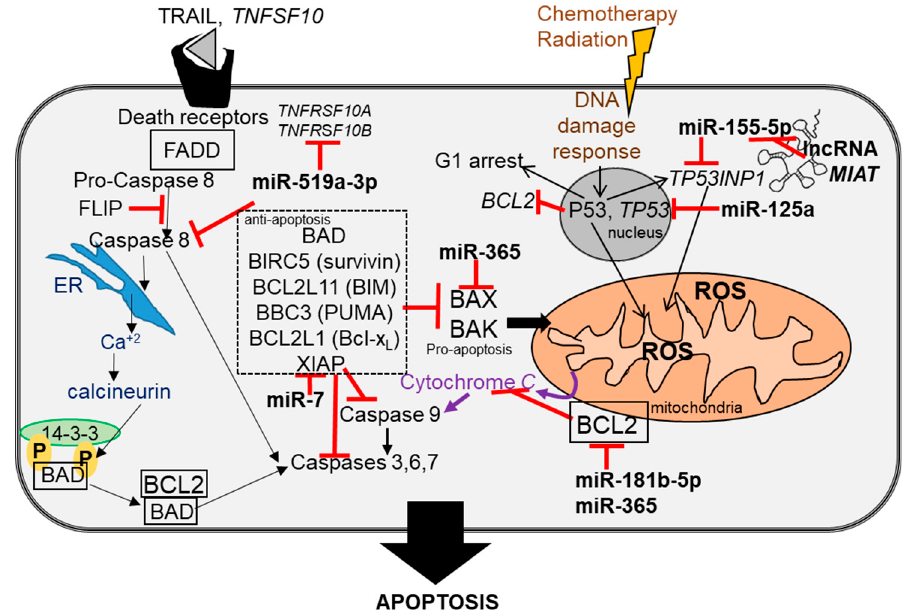
Figure 3. Breast cancer dysregulated miRNAs in apoptosis. Shown in abbreviated form are key regulators in the intrinsic and extrinsic pathways of apoptosis and their regulation by miRNAs that are dysregulated in breast tumors (Tables 2 and 3). The lncRNA MIAT is a ceRNA for miR-155-5p (Table 2).